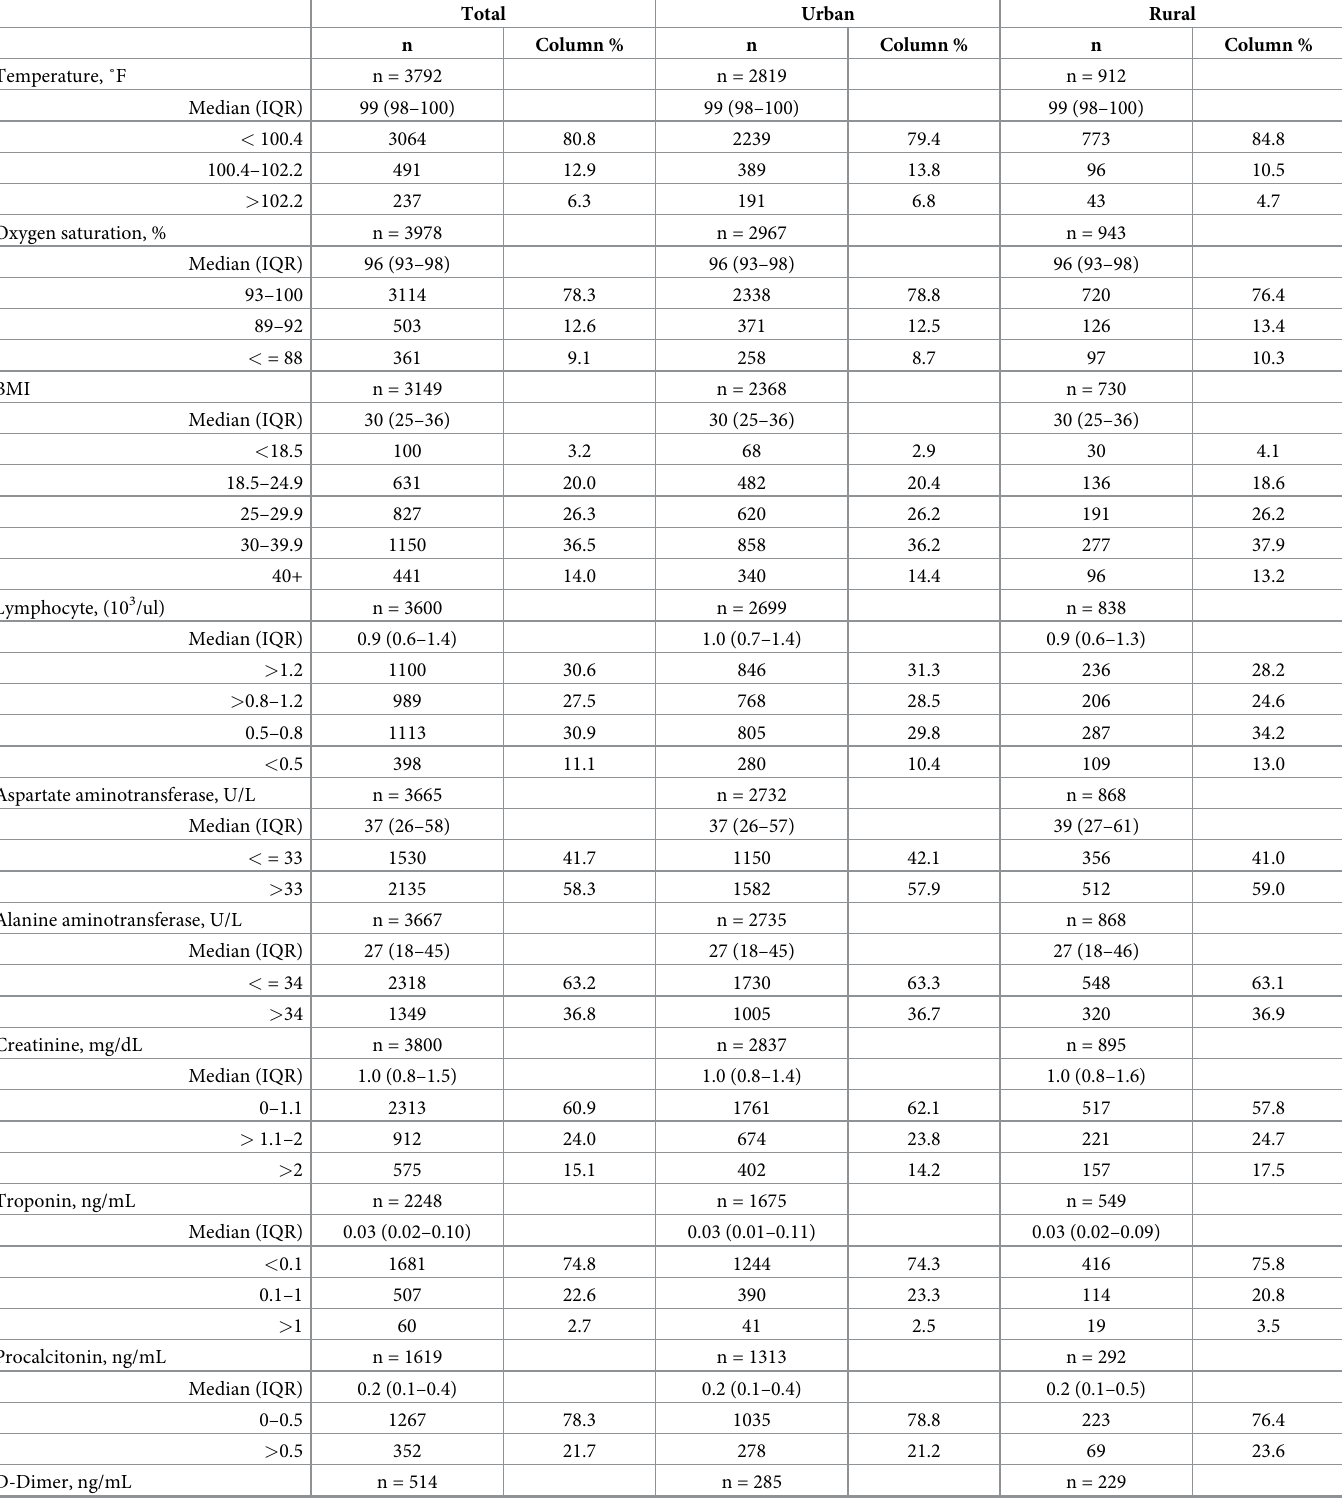
Table 3. Initial vitals and labs of patients hospitalized with a SARS-CoV-2 infection or COVID-19 diagnosis, total and stratified by rural/urban zip codes. Total Urban Rural n Column % n Column % n Column % Temperature, ˚F n = 3792